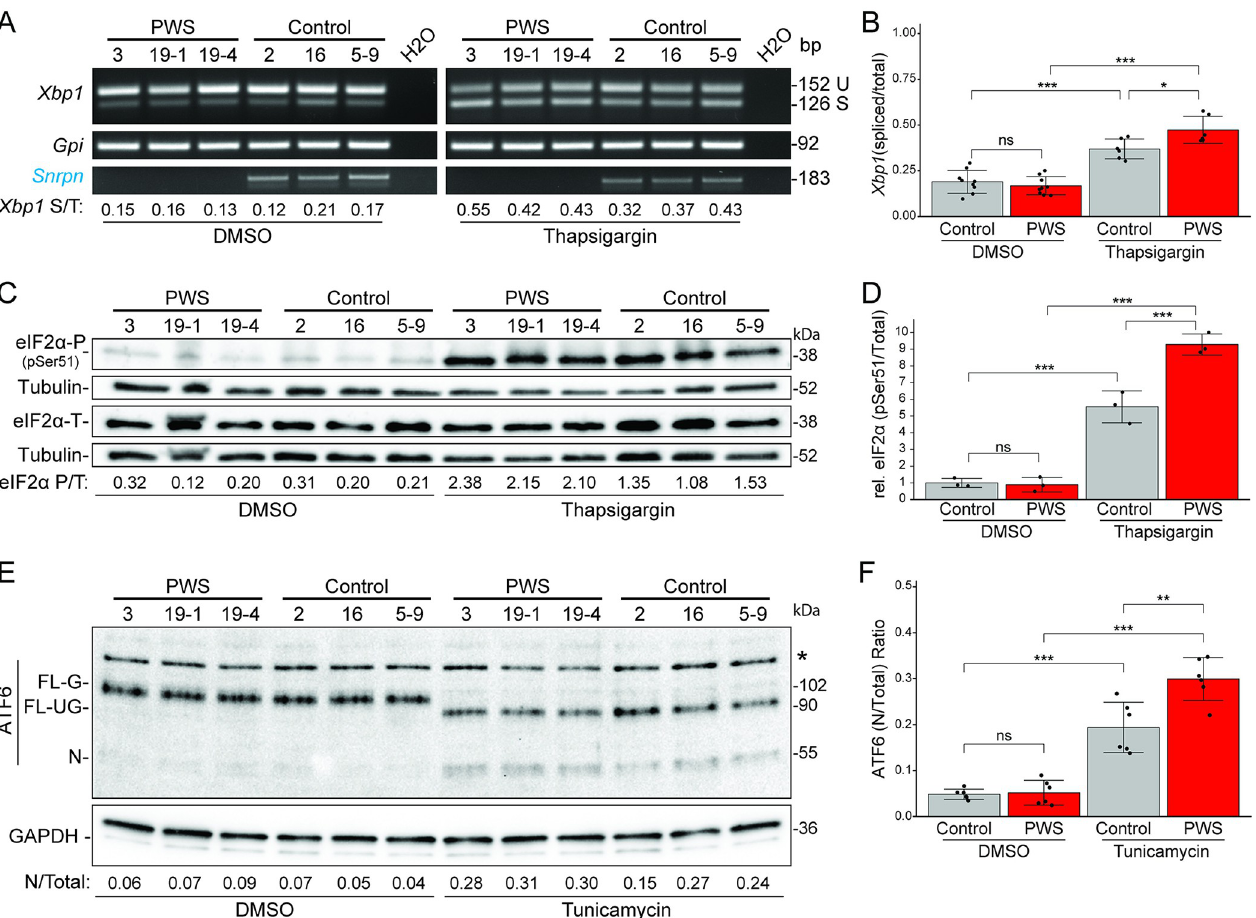
Fig 6. More sensitive activation of all three ER stress master regulatory pathways in PWS-deletion vs . control INS-1 β -cell lines. (A) For the IRE1 α pathway, we assessed its mRNA processing of Xbp1 from unspliced (U) to spliced (S), with control gene Gpi and PWS- Snord116 also assayed by RT-PCR, using RNA from PWS (3, 19–1, 19–4) and control (5–9, 2, 16) INS-1 cell lines treated with DMSO or 0.1 μ M thapsigargin for 3 h. At bottom, the Xbp1 S/T (spliced/ total) ratios for each cell line are shown, under both control (DMSO) and ER stress (thapsigargin) conditions. (B) Quantitation of the ratio of spliced/total (S/ T) Xbp1 mRNA in the PWS and control INS-1 lines under untreated (DMSO; n = 9 each genotype) and thapsigargin (3 h; n = 6 each) conditions. PWS β -cells are more sensitive to thapsigargin-induced ER stress with earlier and more robust activation of Xbp1 mRNA “splicing” than control cell lines. (C) The PERK pathway was assessed by comparison of PERK phosphorylated eIF2 α -P (pSer51) to total eIF2 α , using whole cell lysates from PWS and control INS-1 cell lines treated with DMSO or 0.1 μ M thapsigargin for 5 h. Anti- α TUB was used as a control for protein-loading levels. At bottom, the eIF2 α P/T (phosphorylated/ total) ratios for each cell line are shown under the untreated (DMSO) and ER stress (thapsigargin) conditions. (D) Quantitation of the relative (rel.) level of phosphorylated (pSer51) to total eIF2 α in the PWS and control INS-1 lines (n = 3 each) under untreated (DMSO) and thapsigargin conditions. PWS cells are more sensitive to thapsigargin-induced ER stress with more robust activation of eIF2 α phosphorylation. (E) For the ATF6 pathway, we used whole cell lysates from PWS and control INS-1 cell lines treated with DMSO or 10 μ g/ml tunicamycin for 5 h. Under control DMSO conditions, full-length (FL) and glycosylated (G) ATF6 of ~ 100-kD is ER-localized. Tunicamycin inhibits biosynthesis of N-linked glycans, resulting in unglycosylated (UG) ATF6-FL of 90-kD in the ER, with proteolytic processing in the Golgi to produce nuclear (N) ATF6-N of ~ 55-kD. * , non-specific band detected by the anti-ATF6 antibody. Anti-GAPDH was used as a control for protein-loading levels. At bottom, the ATF6 N/Total (nuclear/Total) ratios for each cell line are shown under untreated (DMSO) and ER stress (tunicamycin) conditions. (F) Quantitation of the ratio of ATF6 nuclear/Total (N/Total) in the PWS and control INS-1 lines under untreated (DMSO) and ER stress (tunicamycin) conditions (n = 6 each, from two biological replicates). PWS cells are more sensitive to tunicamycin-induced ER stress with more robust activation of ATF6-N. For (B , D , F) ,statistical comparison by ANOVA with Tukey’s HSD post-hoc test: * , P < 0.05; ** , P < 0.005; *** , P < 0.0005; ns, not